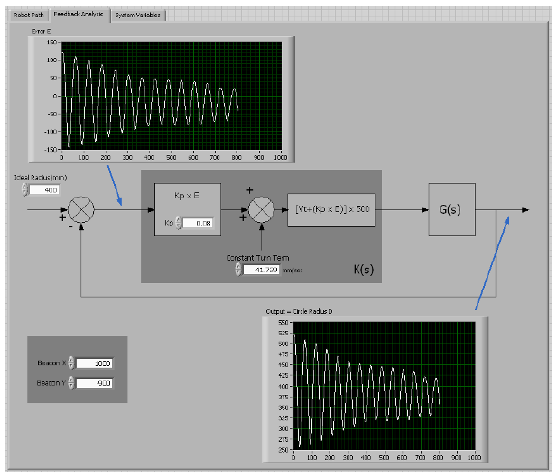
Figure 15. Implemented Proportional-Only Circular Motion Controller Code